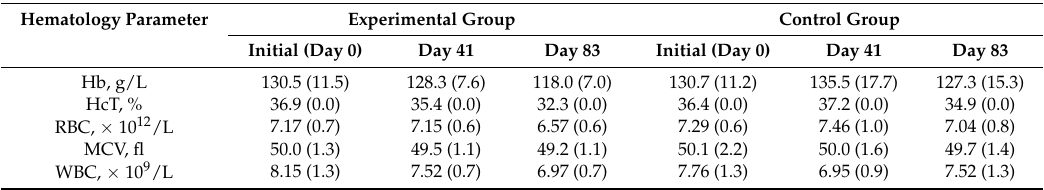
Table 4. Hematology (mean, (s.d)) of the groups during the study period. Hematology Parameter Experimental Group Control